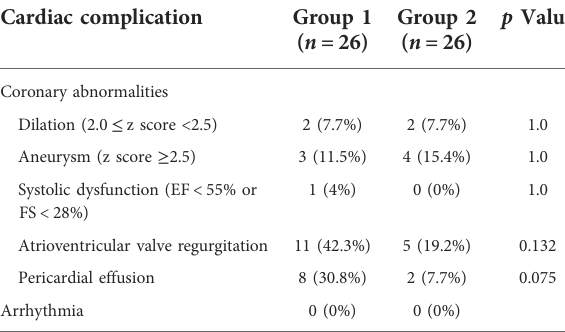
TABLE 6 Comparison of cardiac complications in the acute phase between the two groups.